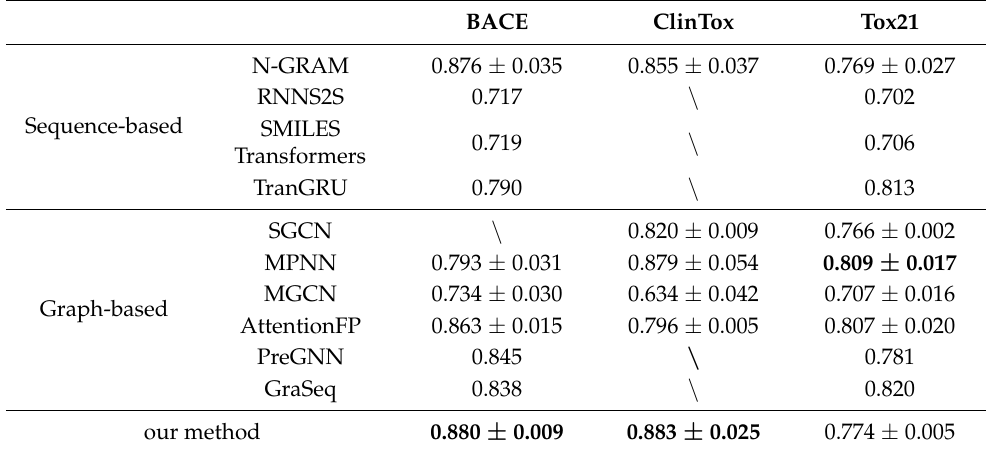
Table 4. ROC–AUC scores of classification tasks on test sets. The values in boldface represent the best prediction performances with the corresponding